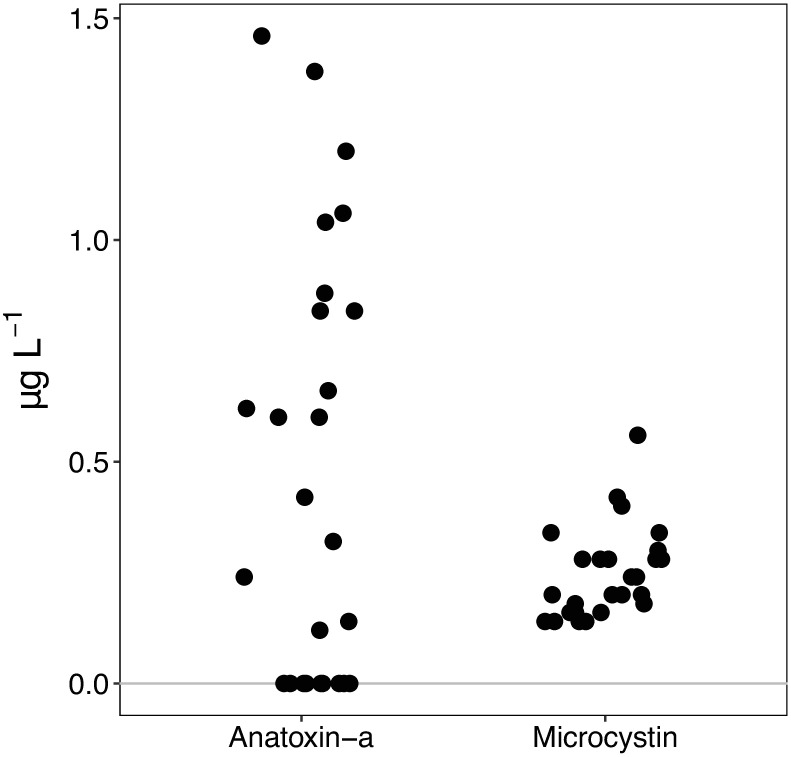
Total anatoxin-a and microcystin concentrations (dissolved plus lysed suspended cells) in unfiltered water samples collected in summer 2015 in the Eel River.